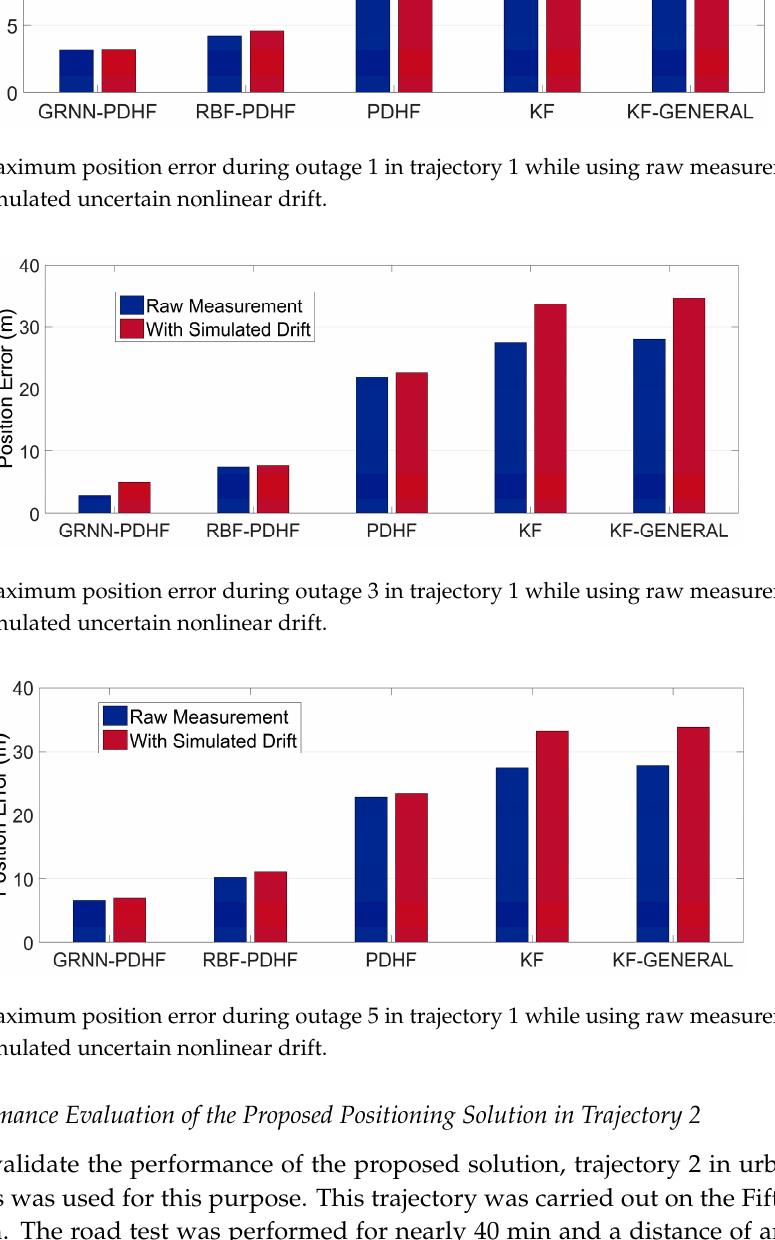
Figure 13. Road-test trajectory 2 with GPS outages indicated.